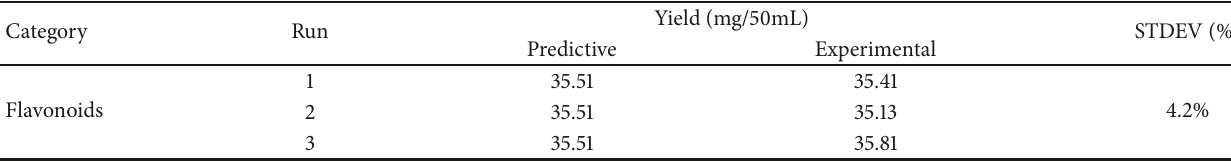
Table 7: Verification of the experimental results.